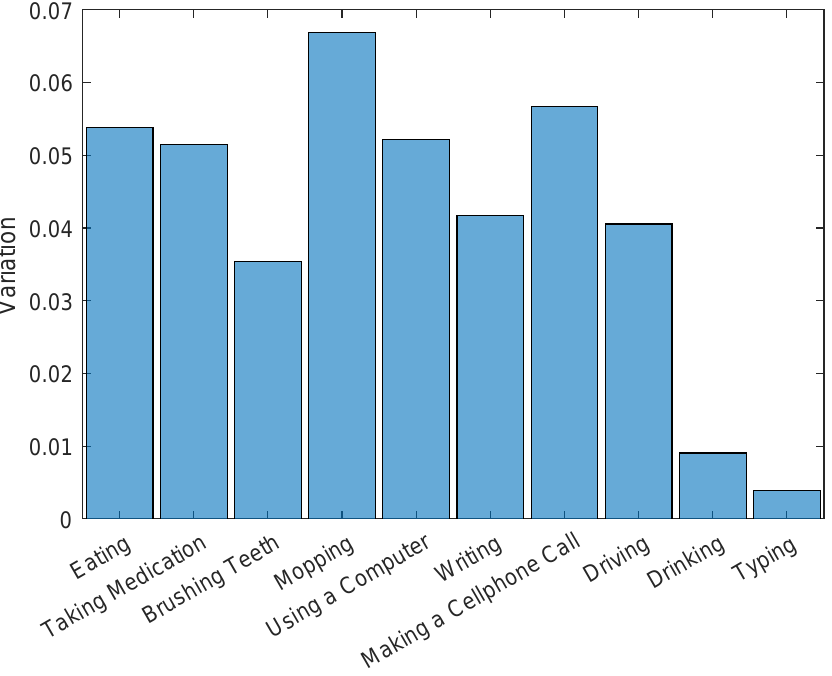
Figure 6. Variation values normalized by activity